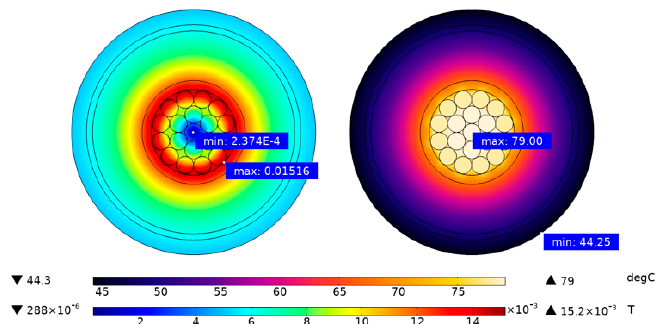
Figure 9. Distribution of the temperature field in °C ( right ) and the magnetic field in T ( left ) in equilibrium.